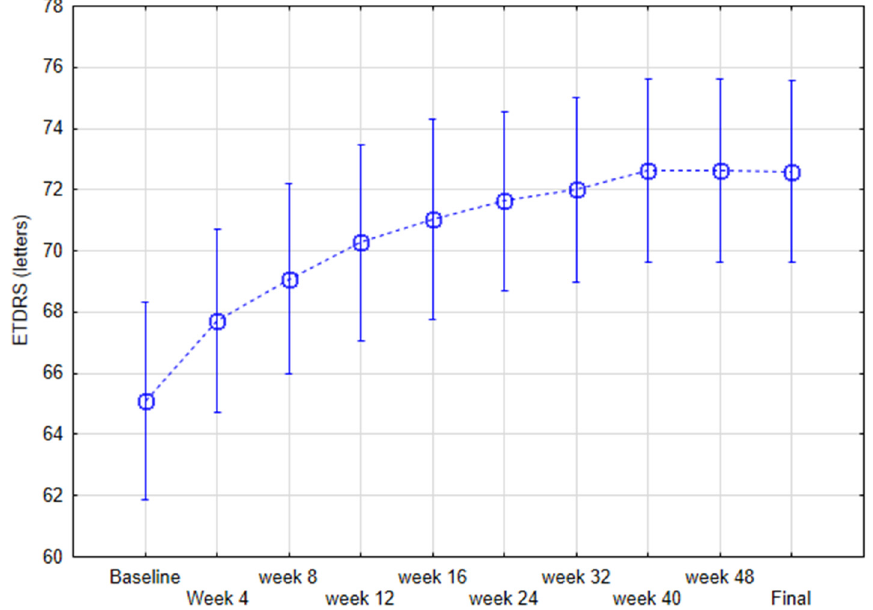
Figure 2. Early Treatment Diabetic Retinopathy Study (ETDRS) scores during the course of the study measured with repeated measures ANOVA current effect: F(9, 225 = 39.334, p < 0.001).